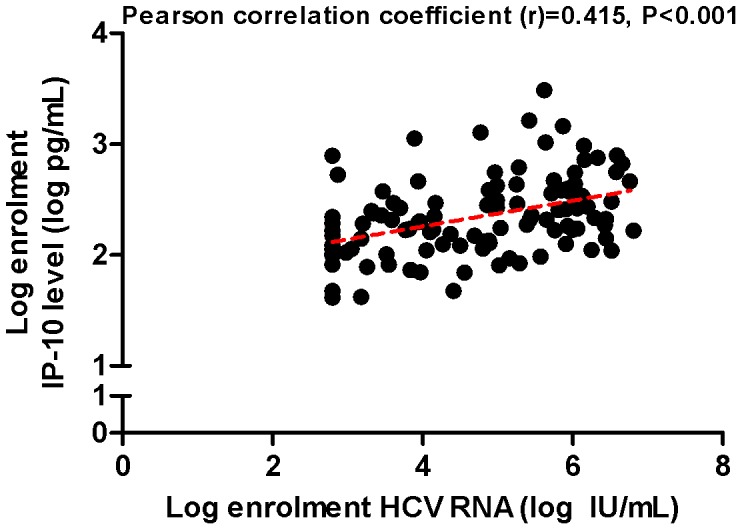
Correlation of baseline plasma IP-10 and HCV RNA titre.The correlation between baseline plasma IP-10 level and serum HCV RNA titre was evaluated using Pearson’s correlation co-efficient.